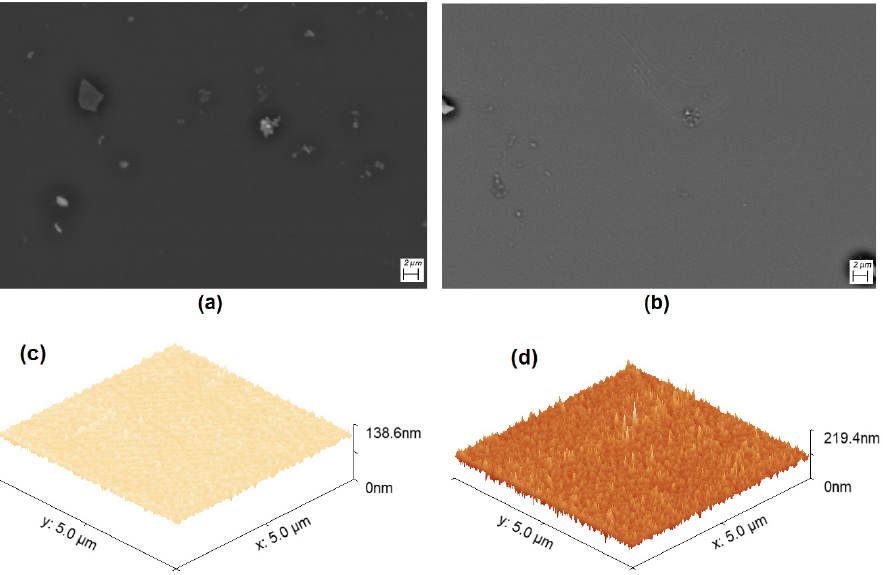
Figure 4. SEM microphotographs of ( a ) TiOPc and ( b ) TiCl 2 Pc films at 5000 × . AFM images of ( c ) TiOPc and ( d ) TiCl 2 Pc